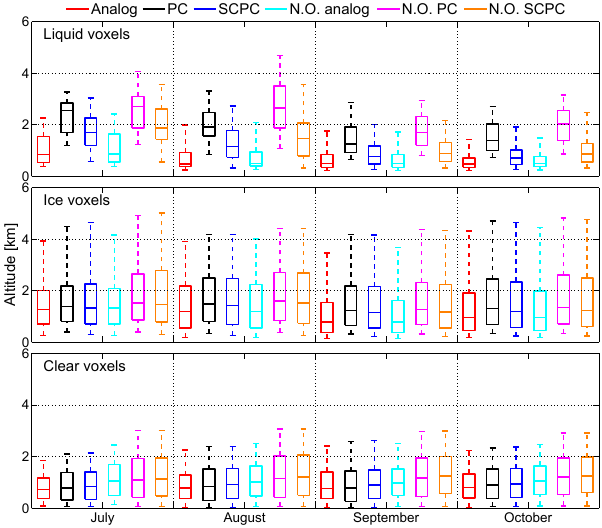
Figure C1. CAPABL data from July 2015 to October 2015 binned into liquid, ice, or clear air. The median is indicated by a line through the box, the 25th to 75th percentile ranges complete the box, and the whiskers extend to the 5th and 95th percentiles. PC, SCPC, and N.O. stand for photon counting, saturation-corrected photon counting, and non-orthogonal, respectively. The channel sensitivity can be seen looking at the clear voxels where analog is expected to be less sensitive than PC and orthogonal less sensitive than